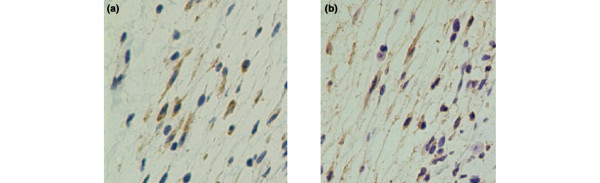
Immunoperoxidase staining of (a) Mac-3 and (b) folate receptor (FR) at an arthritic ankle 72 hours after lipopolysaccharide induction. The Mac-3-positive and FR-positive cells morphologically correlated well in adjacent tissue sections. Magnification, 400 ×.